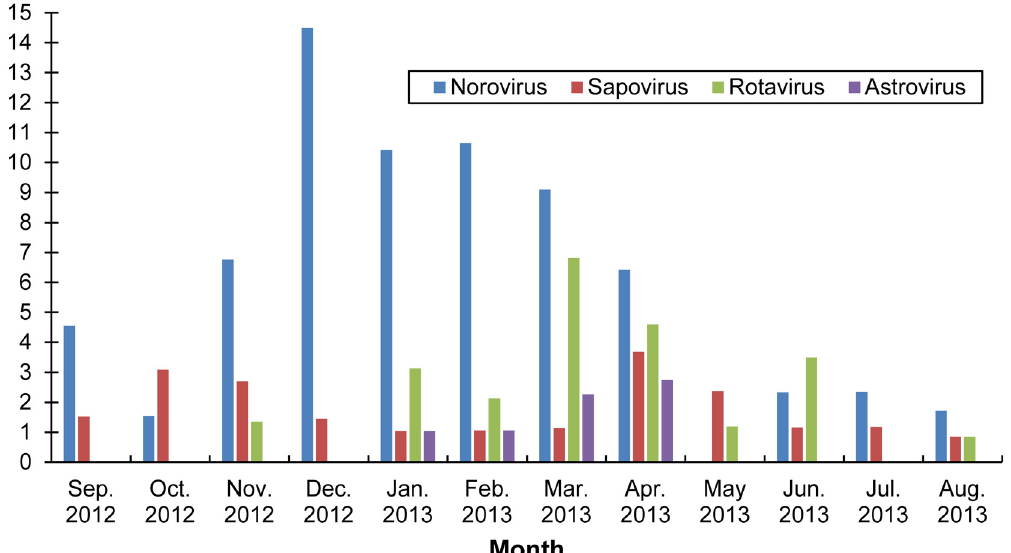
Fig 2. Viral pathogen prevalence in acute gastroenteritis outpatients by season, Kaiser Permanente Northwest and Mid-Atlantic Health Plans, September 2012 – August